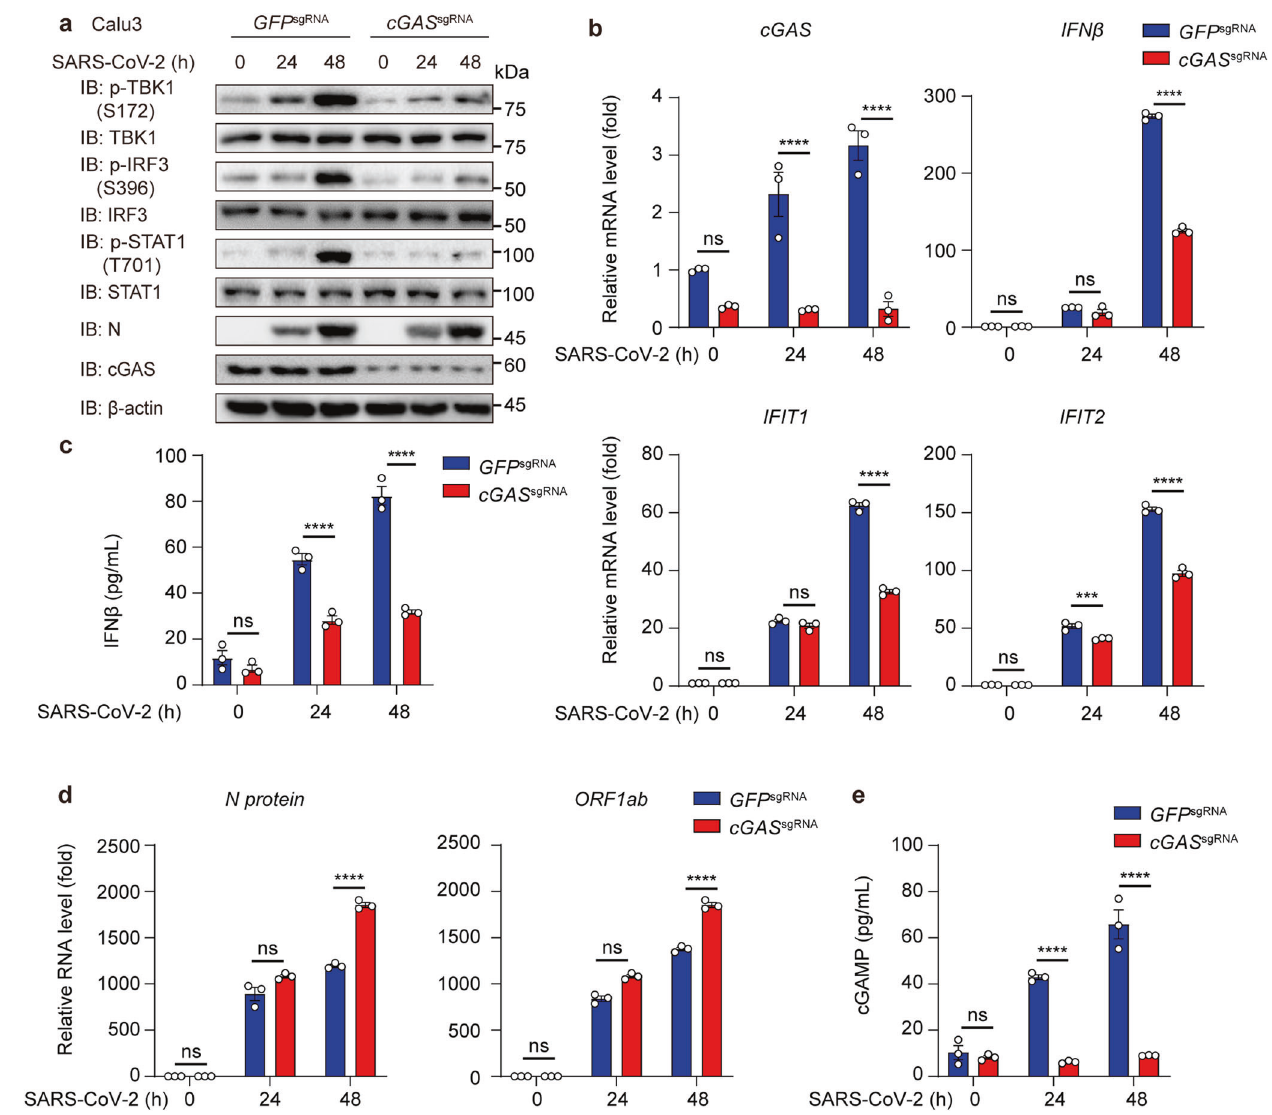
Fig. 2 SARS-CoV-2 infection activates cGAS-mediated IFN-I signaling. a Immunoblot analysis of GFP sgRNA and cGAS sgRNA Calu3 cells infected with SARS-CoV-2 (MOI = 0.1) for indicated time points. b qRT-PCR with reverse transcription analysis of cGAS, IFN β , IFIT1, and IFIT2 mRNA level of GFP sgRNA and cGAS sgRNA Calu3 cells with SARS-CoV-2 (MOI = 0.1) infection for indicated time points. c Cellular IFN β production of GFP sgRNA and cGAS sgRNA Calu3 cells infected with SARS-CoV-2 (MOI = 0.1) for indicated time points detected by ELISA assay. d qRT-PCR with reverse transcription analysis of N protein and ORF1ab RNA of SARS-CoV-2 in supernatant of GFP sgRNA and cGAS sgRNA Calu3 cells with SARS-CoV-2 (MOI = 0.1) infection for indicated time points. e Cellular cGAMP production of GFP sgRNA and cGAS sgRNA Calu3 cells infected with SARS-CoV-2 (MOI = 0.1) for indicated time points detected by ELISA assay. Data in b – e were expressed as mean ± SEM of 3 independent biological experiments. *** P < 0.001, **** P < 0.0001, ns not signi fi cant (unpaired two-tailed student ’ s t -test). Similar results were obtained for 3 independent biological experiments in a N protein counteracts the cGAS-induced IFN-I pathway by impairing cGAS-dsDNA association